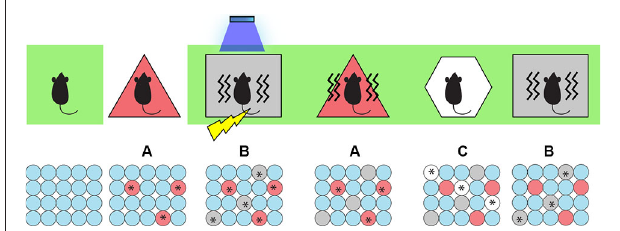
FIGURE 2 | Inception of a false fear memory. Top : The behavior paradigm for the experimental animals. Animals were kept on Dox post-surgery (green background), then taken off Dox and allowed to explore context A to label active cells with ChR2. Then they were put back on Dox and fear conditioned (lightening symbol) in context B while receiving light stimulation (blue shower symbol) to activate cells representing context A. When they were put back to context A, they showed a false fear memory for A (freezing indicated by wavy lines) where they were never actually shocked. They showed no fear memory for a control context C and a genuine fear memory for context B where they were shocked. Bottom : Cellular activity. Red, gray, and white circles indicate neurons representing contexts A, B, and C respectively. Asterisks indicate neurons activated either naturally by contextual exposure or artificially by light